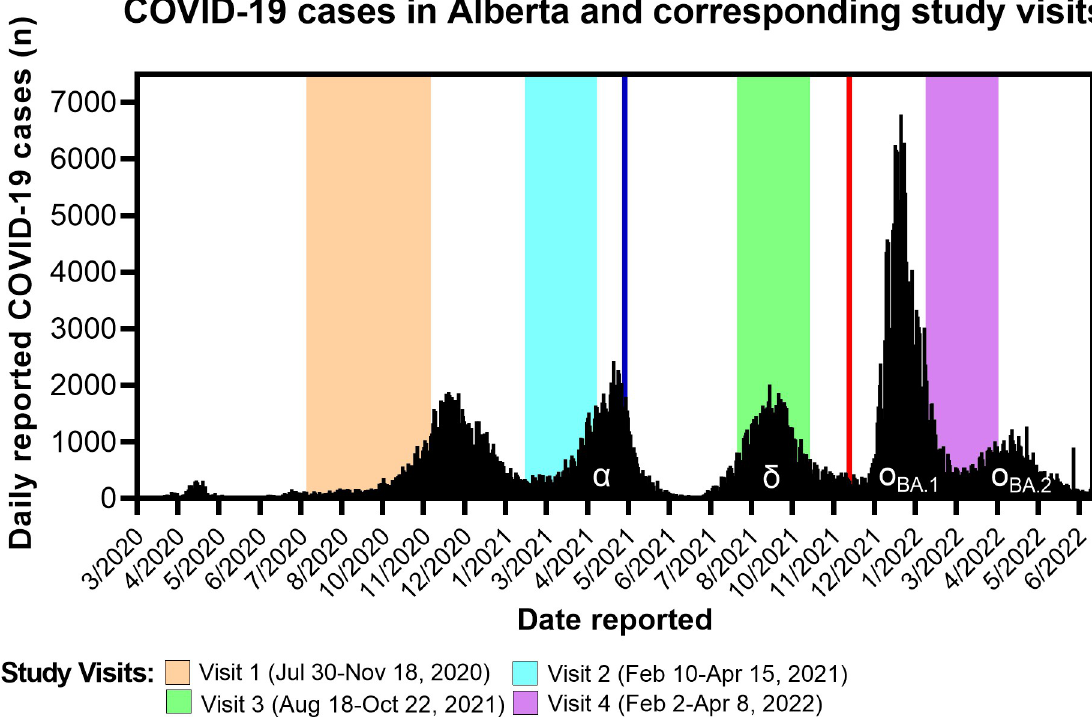
Fig 3. Study visit collection periods with overlay of COVID-19 pandemic curve. Date of vaccine availability for children � 12 (May 10, 2021) indicated by vertical blue line and for children 5–11 years (November 26, 2021) indicated by vertical red line. Main variant of concern indicated by Greek letter α (Alpha B.1.1.7), δ (Delta B.1.617.2), and ο (Omicron